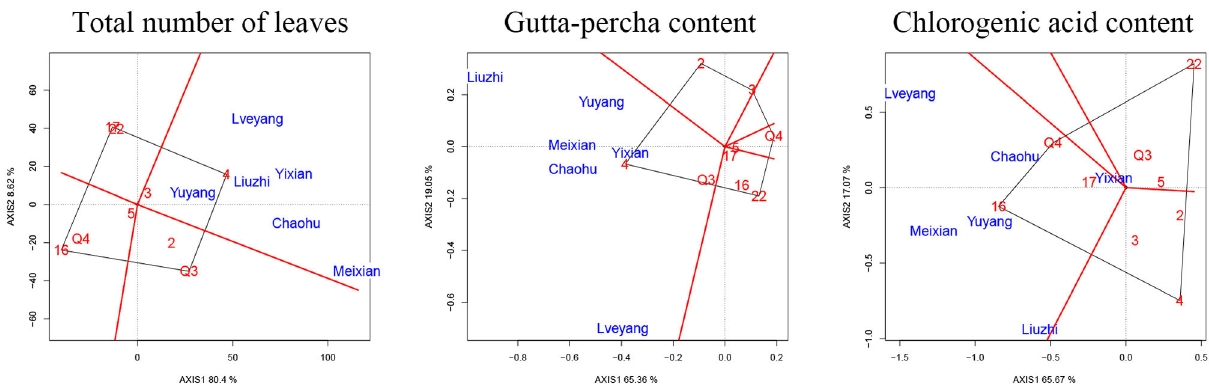
FIGURE 7 | Biplot of the interaction effect. The X-axis and Y-axis are the two principal components. The number or the number and letter combination in red indicates the genotypes of clones. The letter in blue indicates the experimental